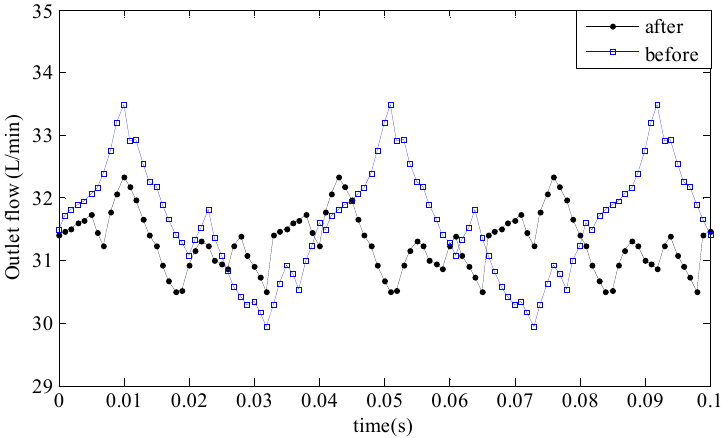
Figure 15. Comparison of outlet flow in the experiment before and after the optimization design.